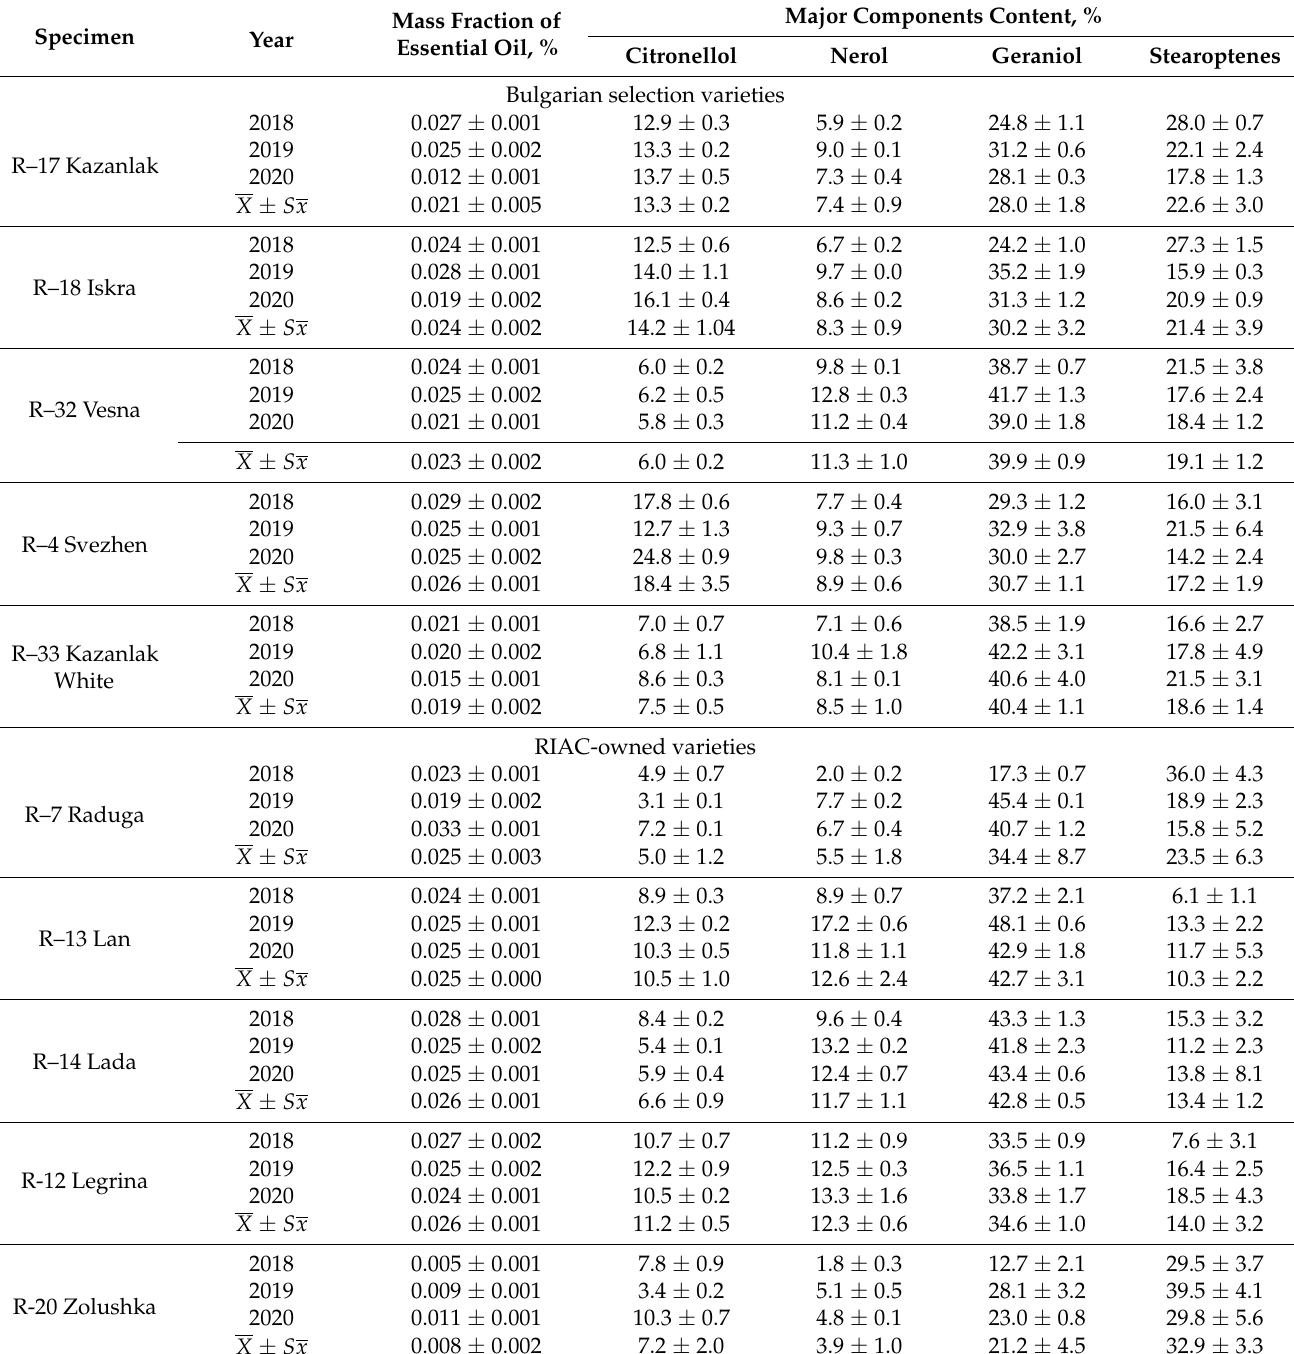
Table 3. The essential oil major component percentages in the collection specimens from